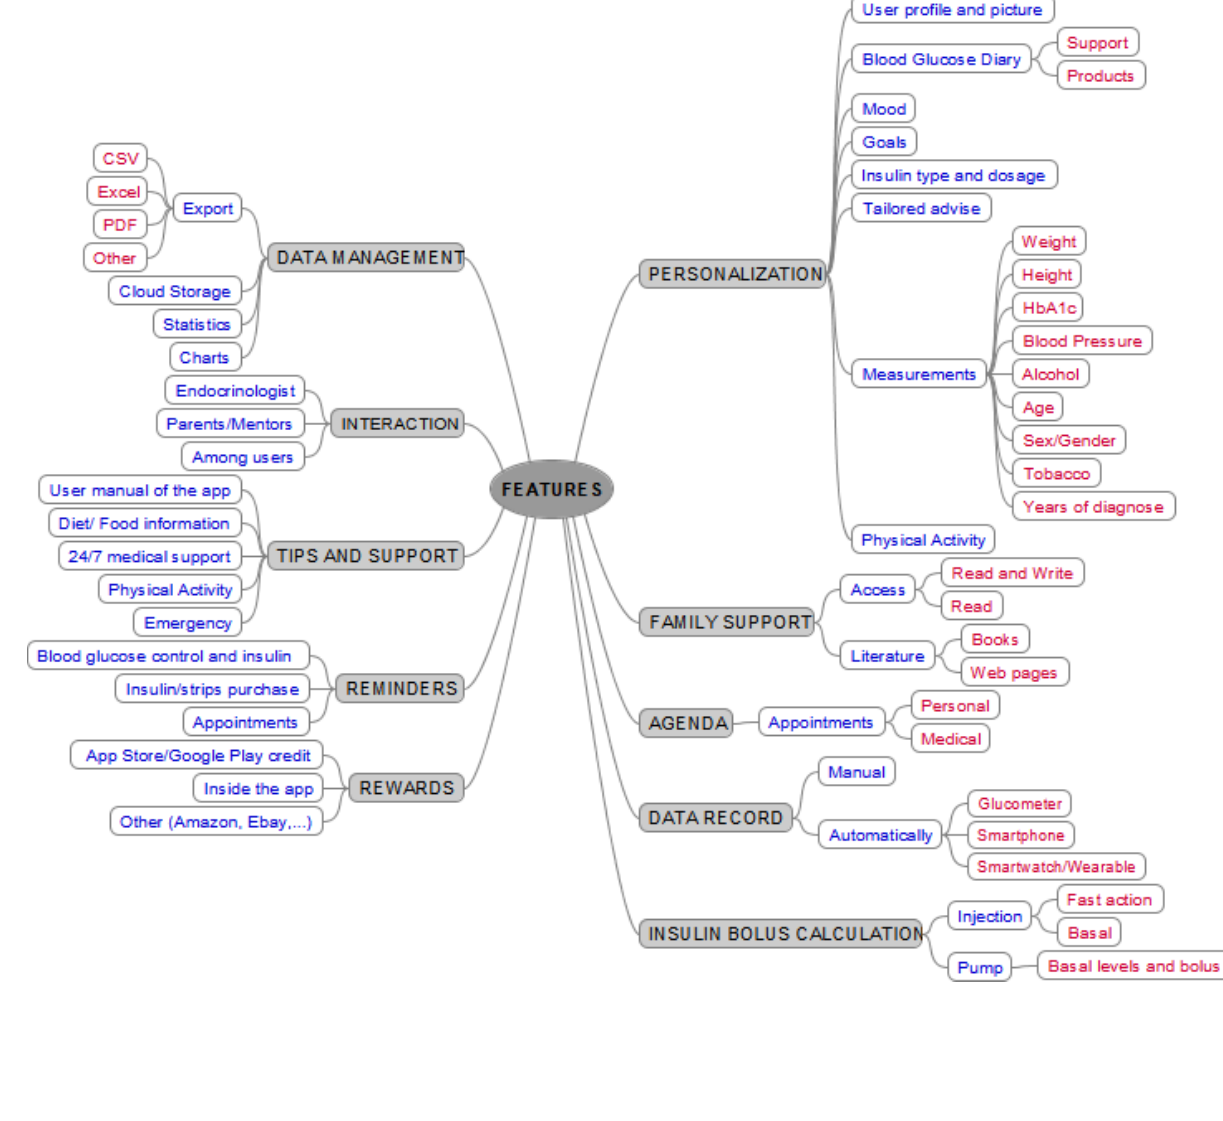
Figure 2. Taxonomy of the features of an ideal app according to the evidence-based effectiveness of mobile health in diabetes support and